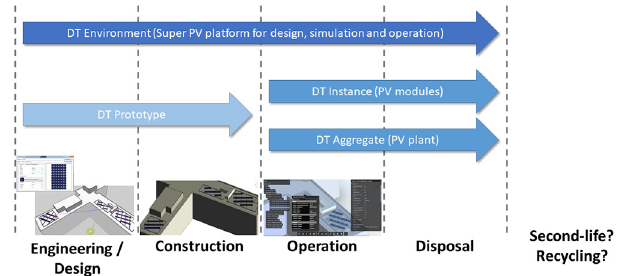
Fig. 8. Digital Twin along the PV